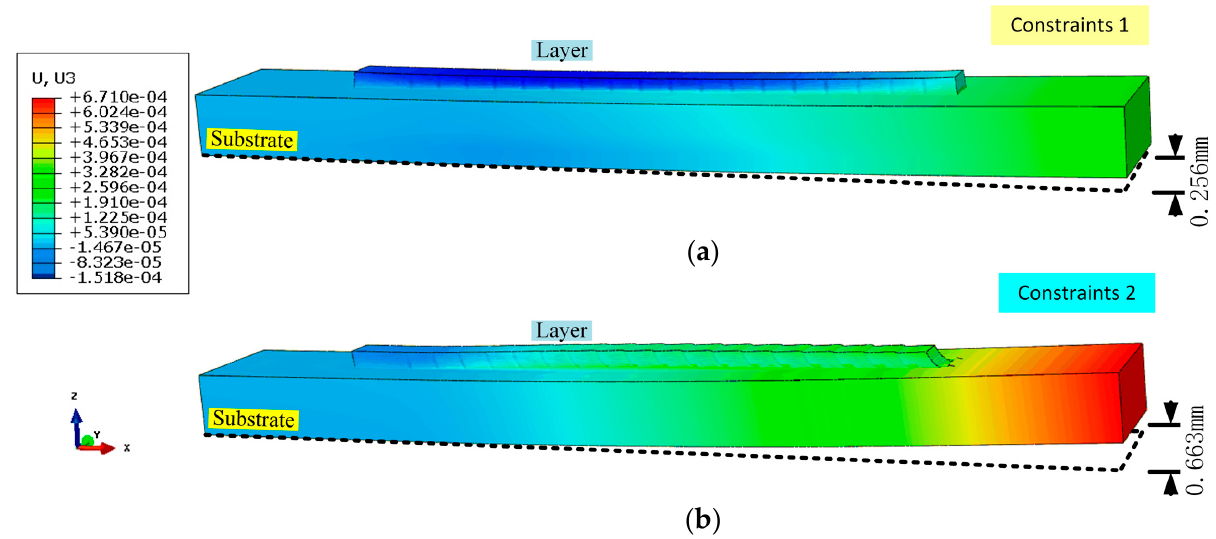
Figure 8. Vertical residual distortions of the deposited thin-walled sample: ( a ) constraints on one end of the substrate; ( b ) constraints on the bottom surface of the substrate.